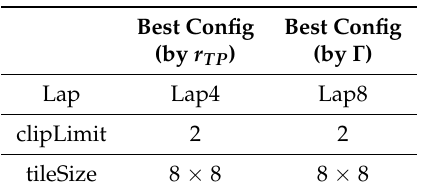
Table 4. Parameters of the best configurations.